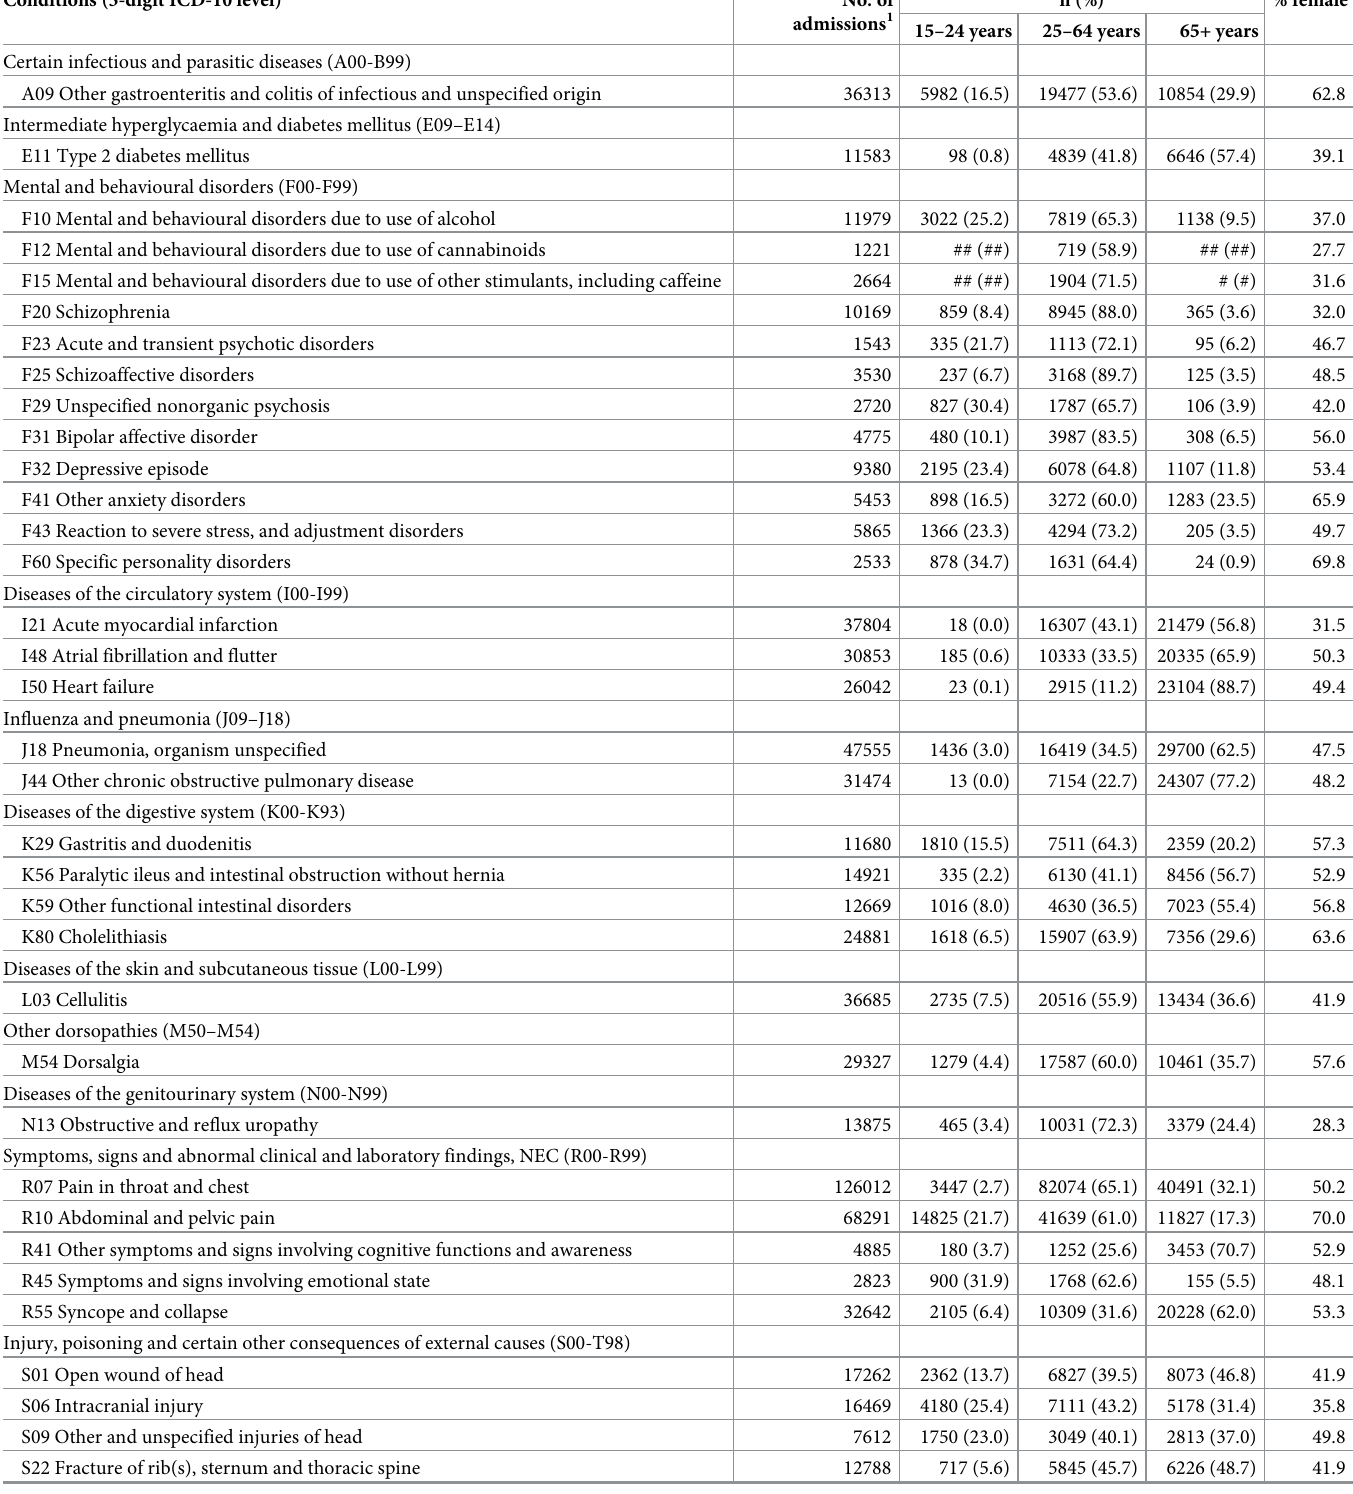
Table 1. Hospital admissions for physical illnesses, mental health conditions and injury by age and gender, Victoria, 2011 to 2016. Conditions (3-digit ICD-10